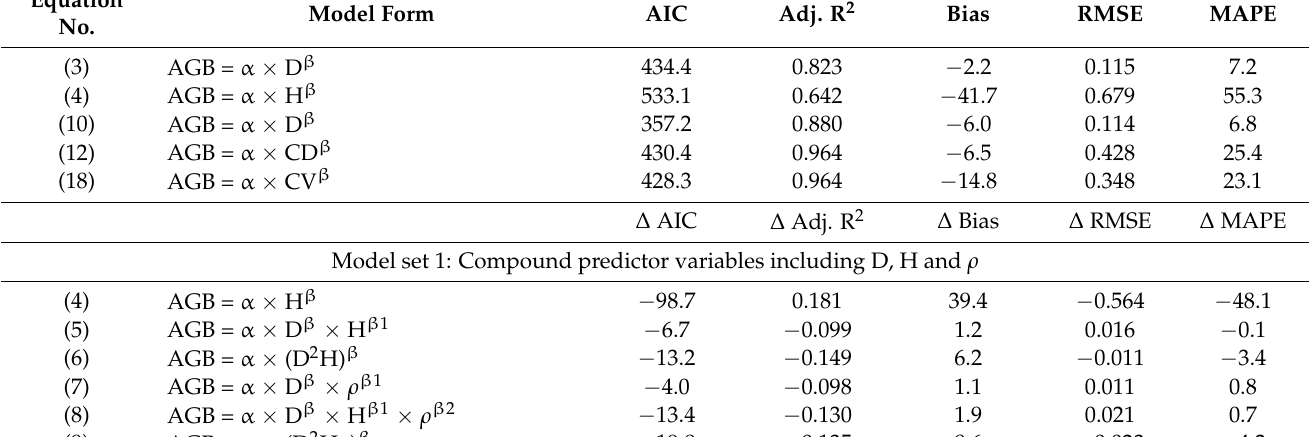
Model set 2a: Compound predictor variables including D, H, ρ and CD